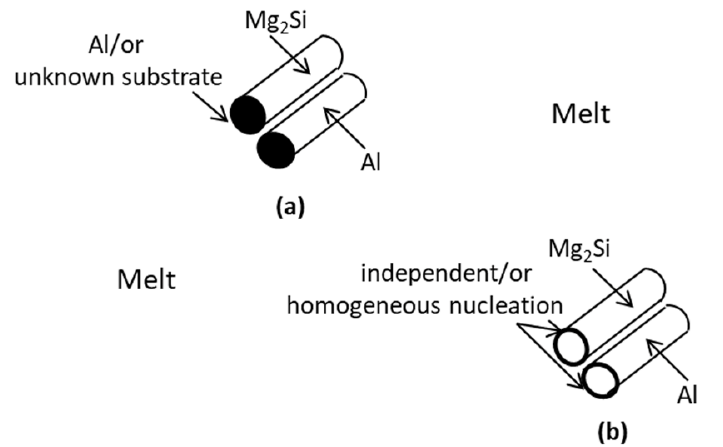
Figure 15. ( a ) Proposed nucleation sequence. Mg 2 Si nucleates on Al/or some unknown substrate whilst Al is nucleating independently or homogeneously, and a decoupled growth occurs at a higher undercooling. ( b ) Both phases nucleate independently at a higher undercooling point and then the eutectic grows in a decoupled manner. This can occur simultaneously at multiple locations in the melt volume, which finally leads to the formation of separate eutectic cells.